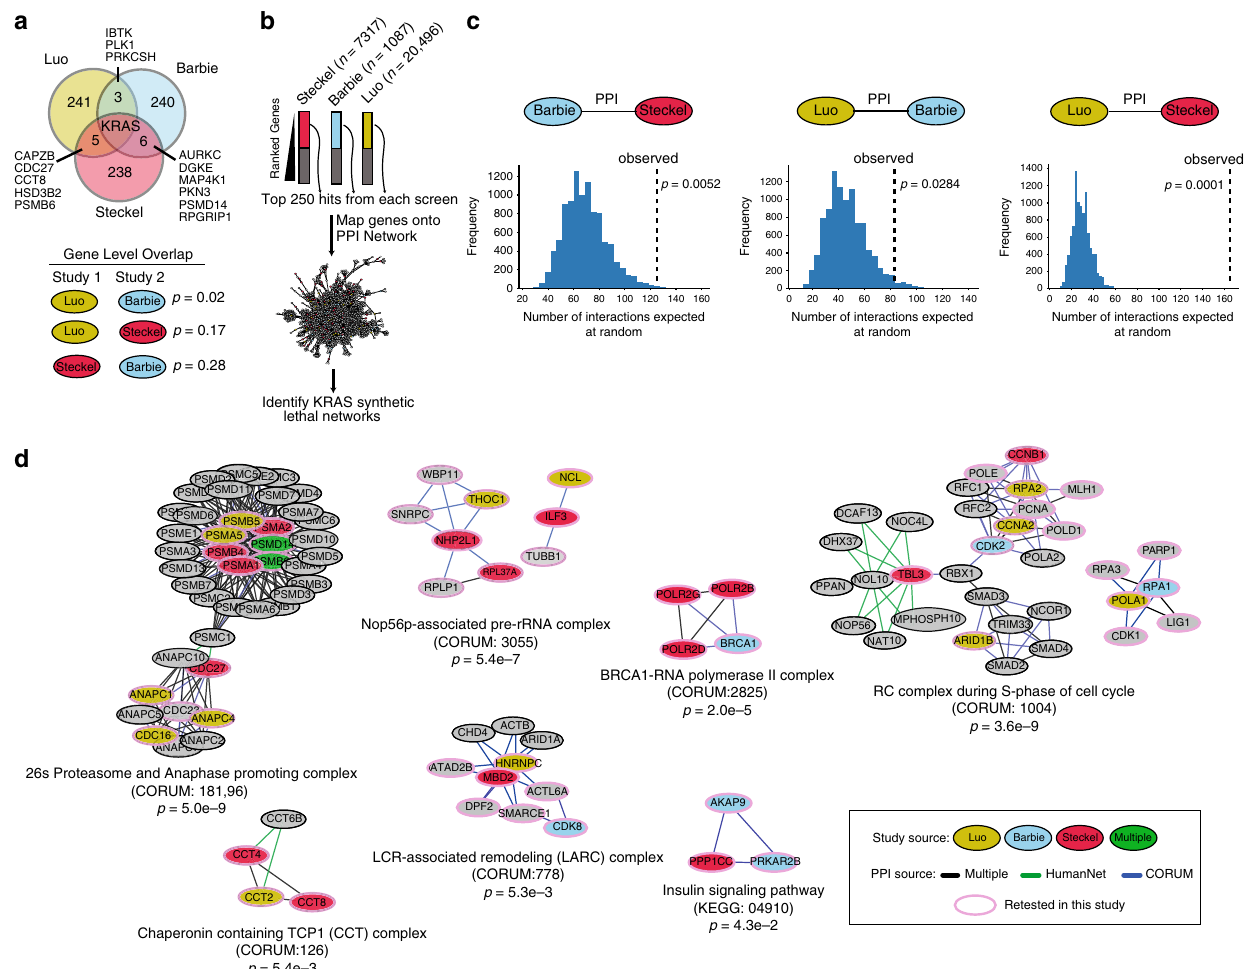
Fig. 1 Meta-analysis of published studies identi fi es common KRAS synthetic lethal networks. a Gene overlap between the top 250 hit genes reported from three published KRAS synthetic lethal studies, Luo et al., and Steckel et al., Barbie et al. 10,12,23 . p values based on two-tailed hypergeometric test calculated between pairwise comparisons taking into account all tested genes per study. b Data integration strategy for mapping top 250 KRAS synthetic lethal reported from each study onto a protein-protein interaction network composed on interactions from HumanNet and CORUM protein complexes. The number of genes that were tested in each study, n . c Comparison of the number of interactions observed in the protein-protein interaction (PPI) network spanning between hits reported in the two indicated studies versus the number of similar interactions observed between random genes. Histogram represents results from 10,000 simulations conducted from randomly picking 250 genes that were tested in each respective study and the p value represents the fraction of simulations where the same or more interactions than the actual observed number were obtained. d The PPI network was limited to interactions where at least one of the proteins was identi fi ed in previous studies and then subjected to network clustering to identify densely connected components using MCODE. Individual subnetworks were fi ltered to those which contained genes from multiple studies and grouped based on gene function into 7 clusters. The set of genes identi fi ed in each subnetwork was assessed for overlap with the CORUM or KEGG complex or pathway listed using a two-tailed hypergeometric